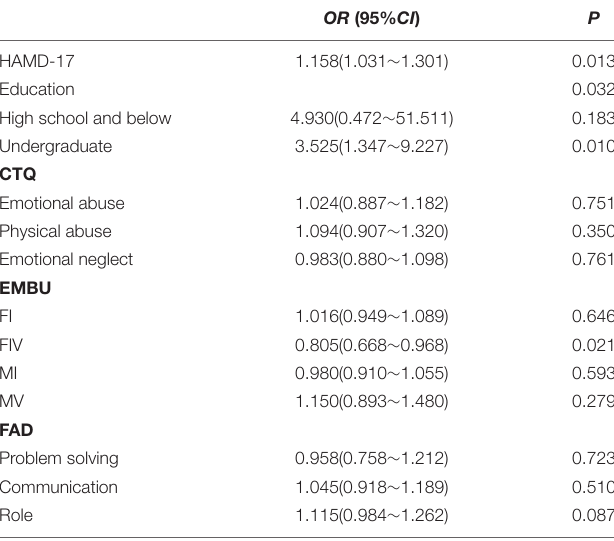
TABLE 2 | Binary logistic regression analysis between non-SRB and SRB.